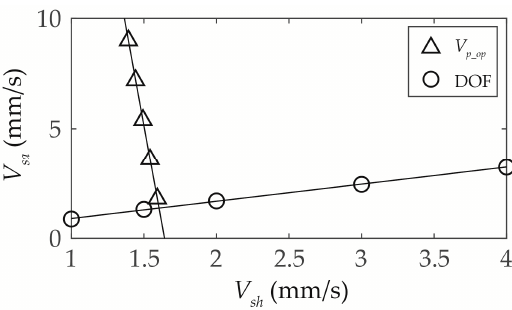
Figure 7. Sample flow velocity V sa as a function of sheath flow velocity V sh when velocity and distribution range of the sample particle are V p_op and DOF, respectively. The intersection of the two fitted lines is the optimised V sh and V sa .